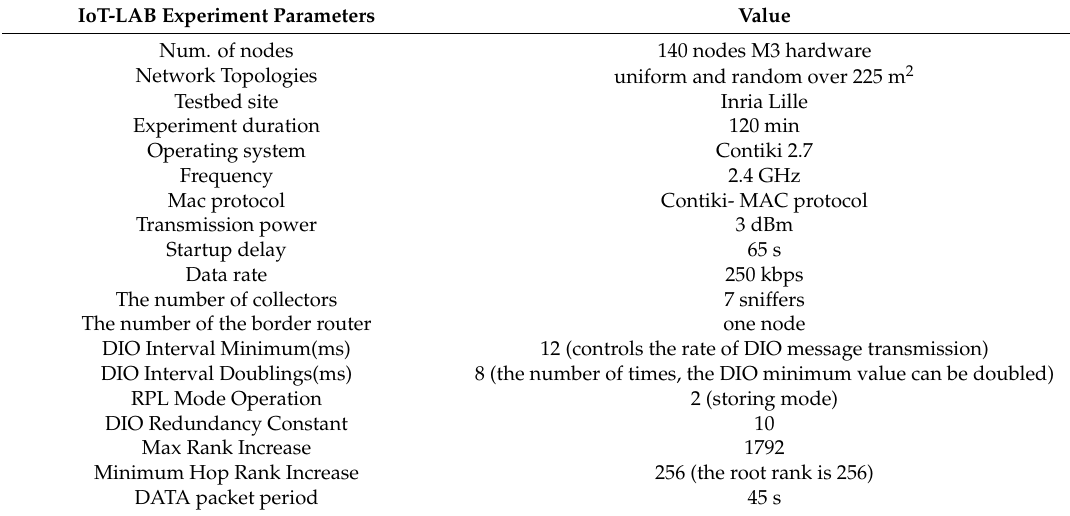
Figure 6. RPL DODAG logical topology using 6LoWPAN Foren6 diagnostic tool. Table 2. IoT‐LAB testbed experiment parameters.